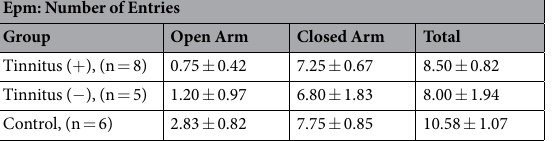
amplitudes of rats blasted under ketamine/xylazine with those blasted under isoflurane (see Supplementary Fig. S2), we also found no significant differences at 28 kHz in the left ear ( F (2,79) = 0.288, p = 0.593) or in the right